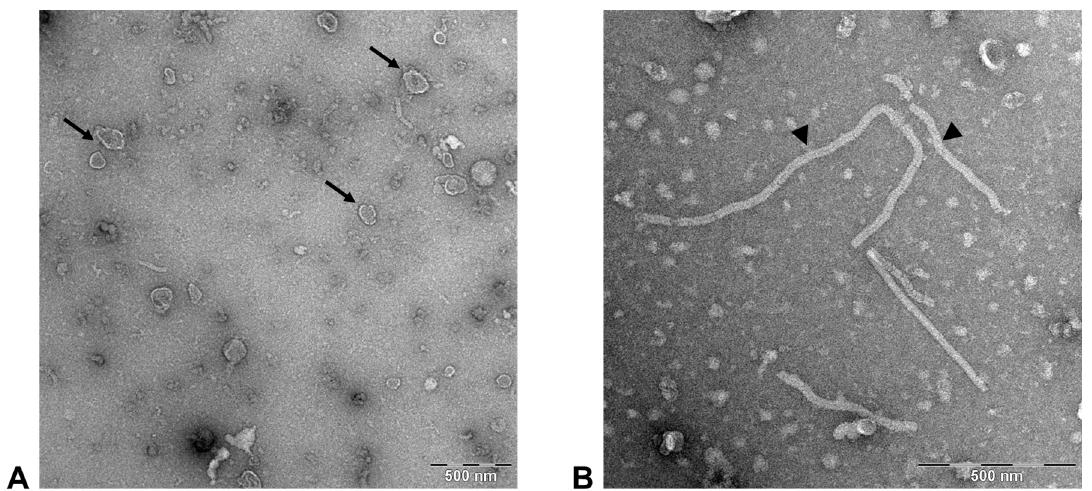
Figure 2. Electron microscopy of FeMV-GT2. Cell culture supernatant of FeMV-GT2-infected LLC-MK2 cells was concentrated via ultracentrifugation and virions were negatively stained using uranyl acetate. ( A ) typical pleomorphic paramyxovirus particles (arrows); ( B ) free nucleocapsids (arrowheads). Scale bar represents 500